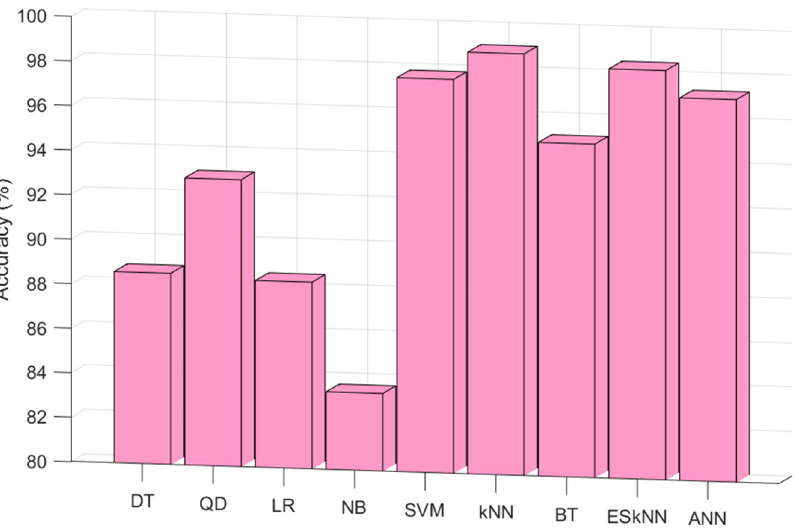
Figure 5. Classification accuracies of the decision tree (DT), quadratic discriminant (QD), logistic regression (LR), naive Bayes (NB), support vector machine (SVM), Fine kNN (kNN), bagged tree (BT), ensemble subspace kNN (ESkNN), and artificial neural network (ANN) for the Fp2 channel with 10-fold cross-validation.